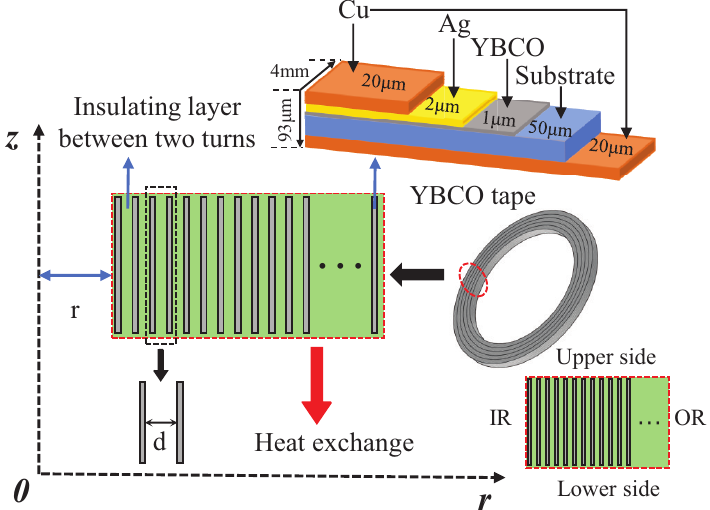
Figure 1. The 2D axisymmetric model of a multi-turn YBCO